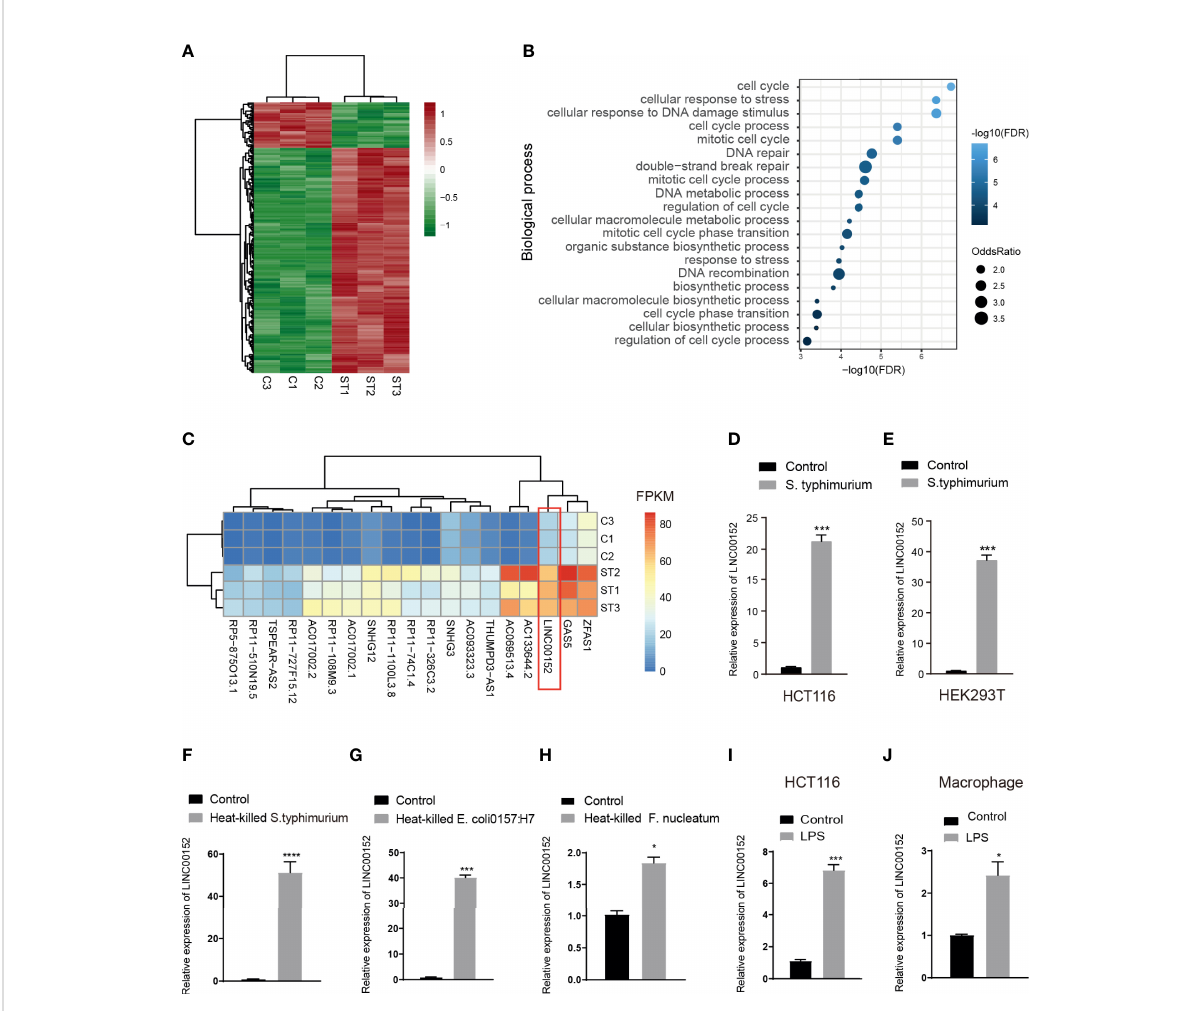
FIGURE 1 LPS induced alteration of lncRNA expression. (A) Heatmap of lncRNA expression in Salmonella infected human intestinal epithelial HCT116 cells (ST) and controls(C). (B) The enriched biological process of differential lncRNAs based on the co-expressed protein-coding genes. (C) The heatmap of the top 20 expressed lncRNA in the control and Salmonella infected HCT116 cells. (D, E) qPCR validation of the elevated expression of LNC_ LINC00152 in the S. typhimurium infected HCT116 cells (D) and HEK293T cells (E) . (F, H) The expression of LINC00152 in the heat- treated gram-negative bacteria-infected HCT116. (I, J) The expression of LINC00152 in the LPS treated HCT116 and macrophage. * P < 0.05; *** P < 0.001 **** P < 0.0001. All experiments were in three